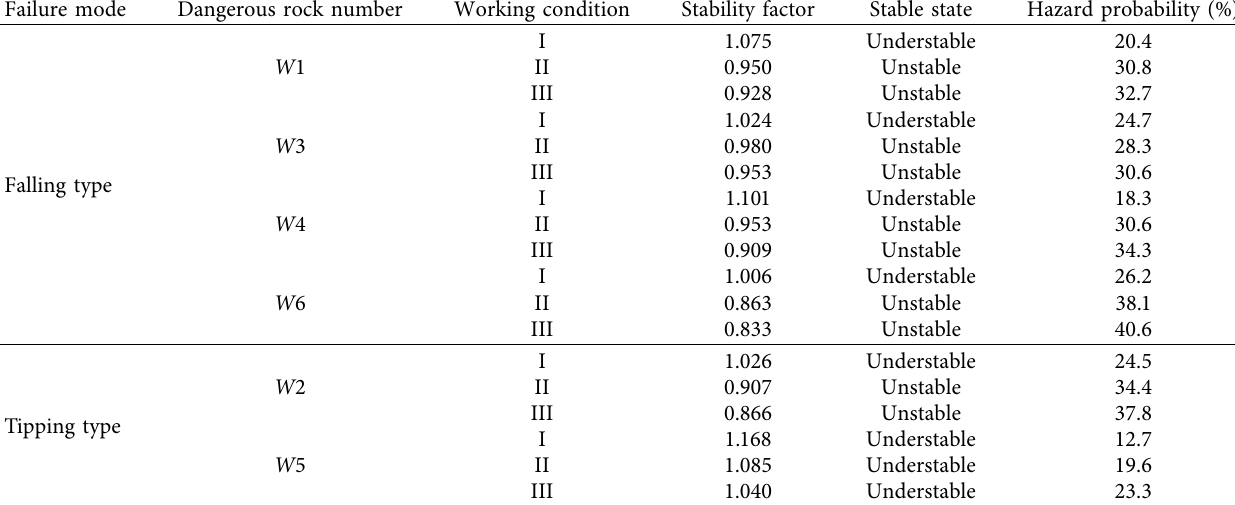
Table 7: Calculation results of dangerous rock